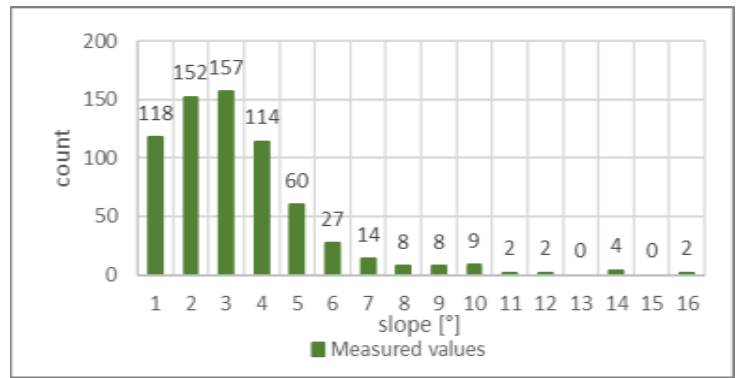
Fig. 2: Counts of measured values